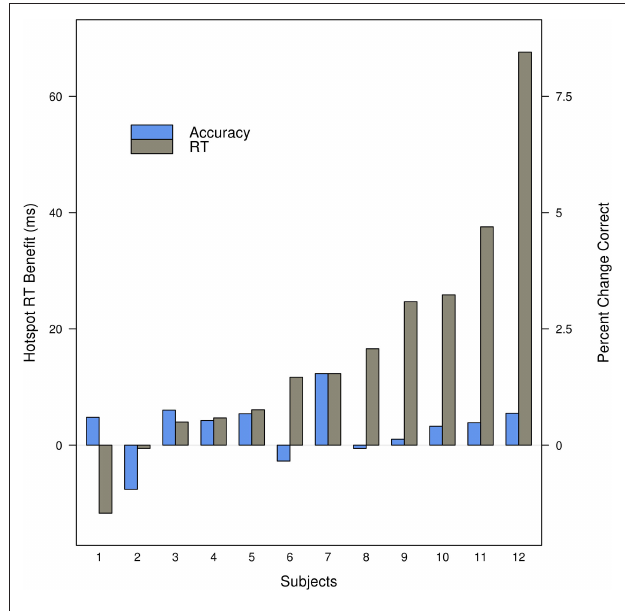
Figure 3 | There is a benefit in rT and accuracy for individual participants when targets from the high-probability, hotspot, side are compared to targets from the low-probability side. Participants are ordered by the magnitude of the RT benefit. Trials with RT < 150 ms or > 1000 ms are excluded, and RT is computed for correct trials